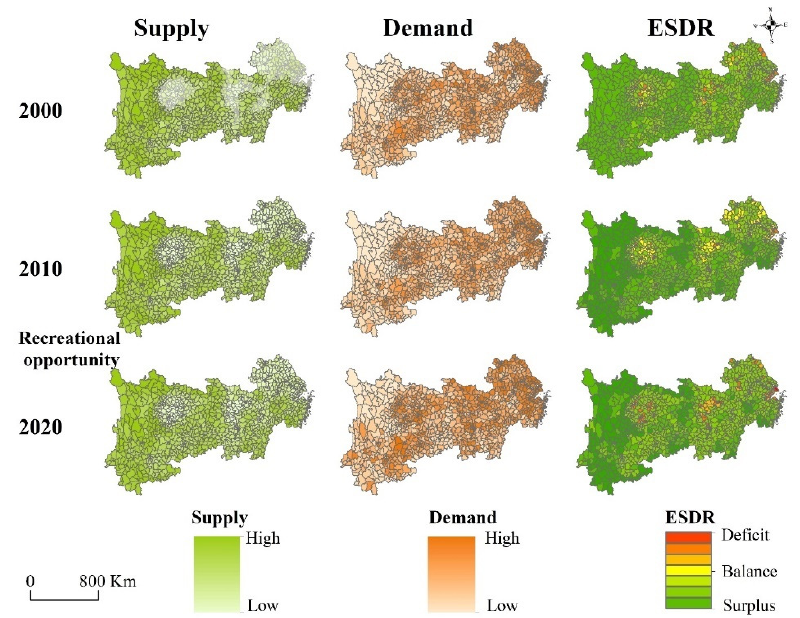
Figure 5. Spatial distribution of supply (left column), demand (middle column), and ESDR (right column) for recreational opportunities in the YREB from 2000 to 2020.